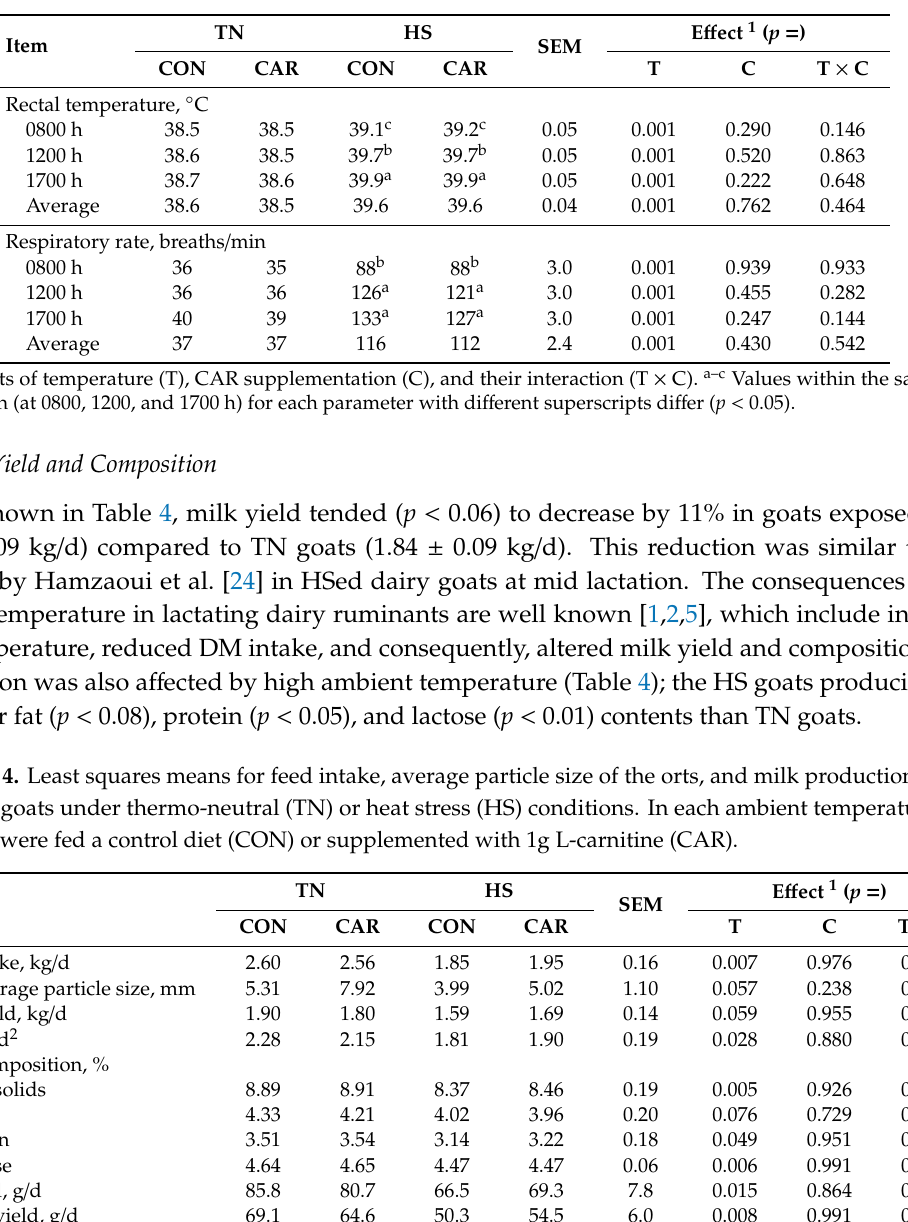
Table 3. Least squares means for respiratory rate and body temperature of dairy goats under thermo-neutral (TN) and heat stress (HS) conditions. In each ambient temperature, goats were fed a control diet (CON) or supplemented with 1g L-carnitine (CAR).